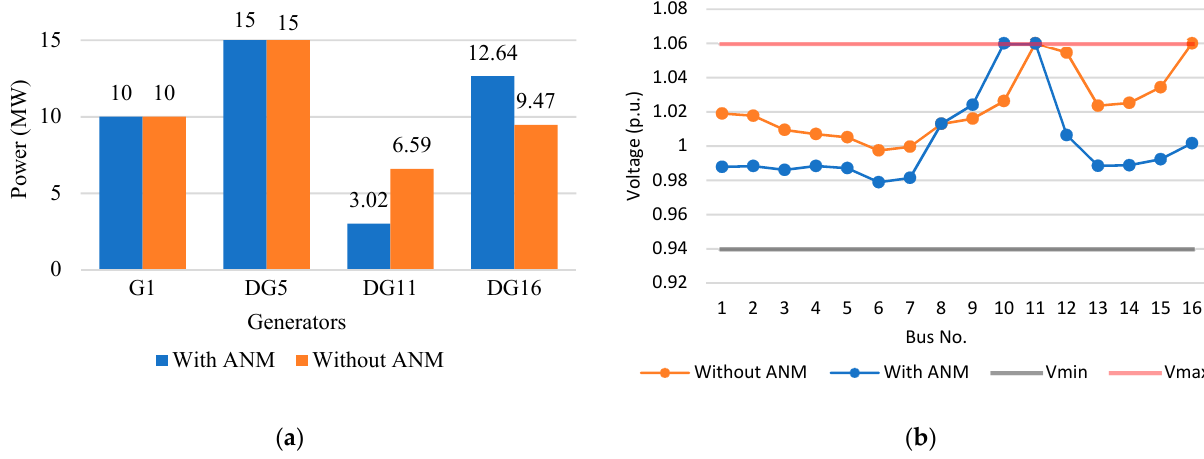
Figure 4. Scenario S7, year Y3: Comparison of planning with and without ANM. ( a ) Power generation from each generator, ( b ) voltage at each bus.